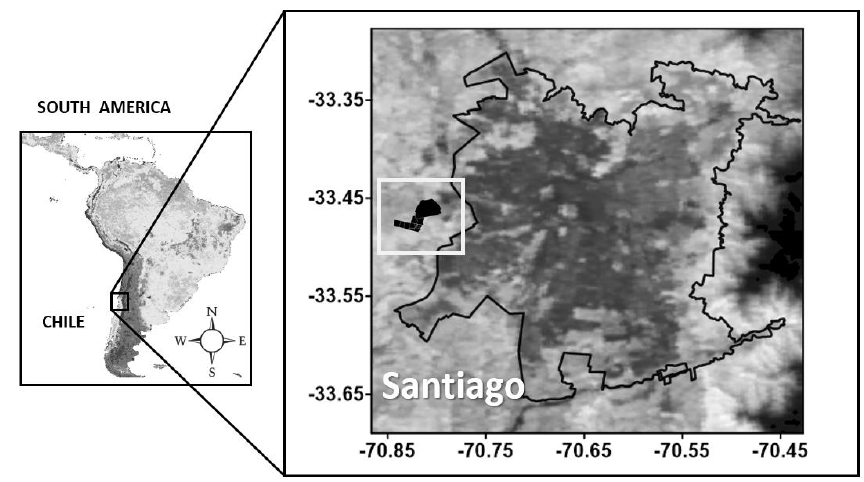
Figure 1. Location of the area where the study was carried out.